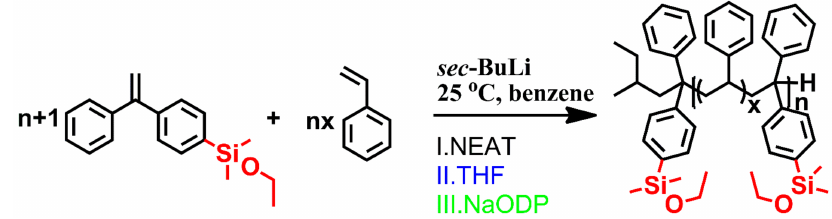
Figure 6. The copolymerization of DPE-SiOEt and styrene initiated by sec -BuLi in benzene at 25 ◦